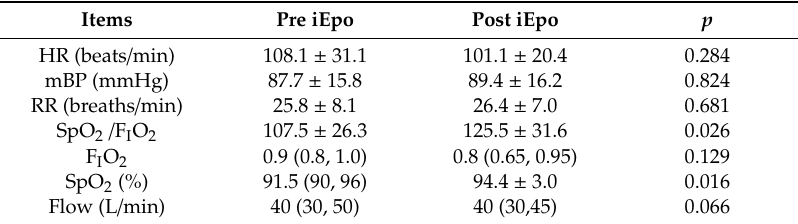
Table 3. Comparison between pre and post